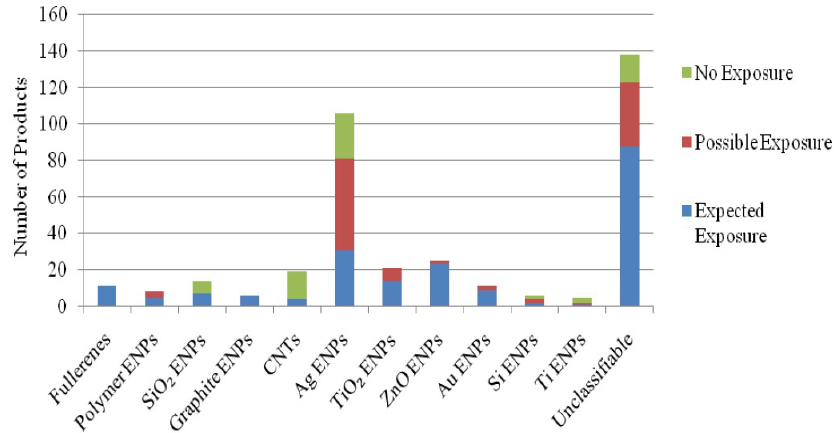
Figure 15. Nanomaterials versus likelihood of exposure [160].